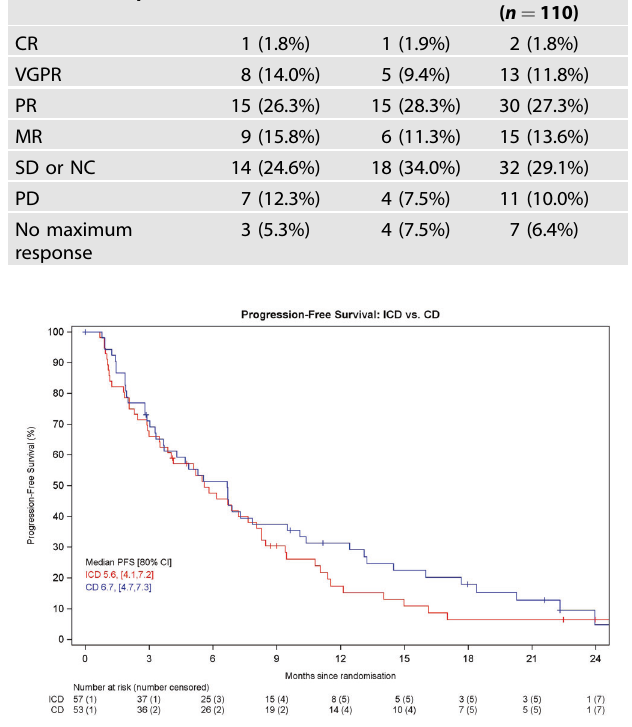
Fig. 2 Progression-free survival.